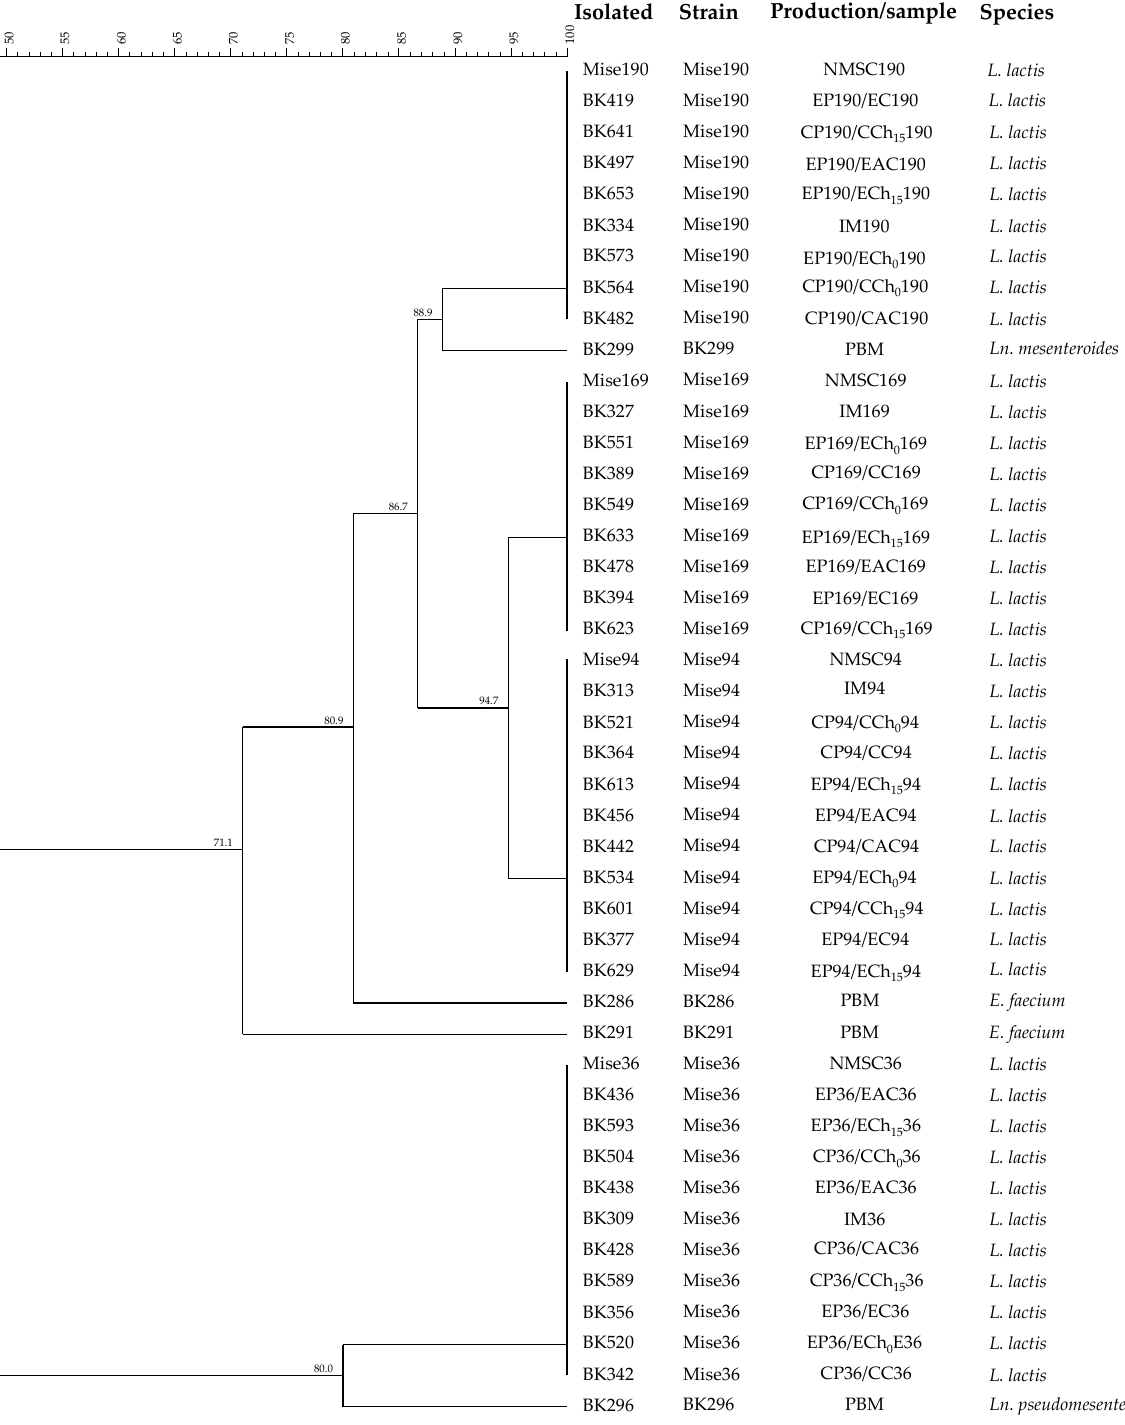
Figure 3. Dendrogram obtained with combined randomly amplified polymorphic DNA (RAPD) ‐ PCR patterns generated with three primers for lactic acid bacteria (LAB) strains isolated during cheese productions. The line at the top indicates percentages of similarity. Abbreviations: L ., Lactococcus ; E. , Enterococcus ; Ln. , Leuconostoc ; BK, Biopek dairy factory; CP, control production; EP, experimental production; IM36, IM94, IM169, and IM190, inoculated milk with L. lactis MISE36, MISE94, MISE169, and MISE190, respectively; CC36, CC94, CC169, and CC190, control curd with L. lactis MISE36, MISE94, MISE169, and MISE190, respectively; EC36, EC94, EC169, and EC190, experimental curd with 1% of GPP and L. lactis MISE36, MISE94, MISE169, and MISE190, respectively; CAC36, CAC94, CAC169, and CAC190, control acidified